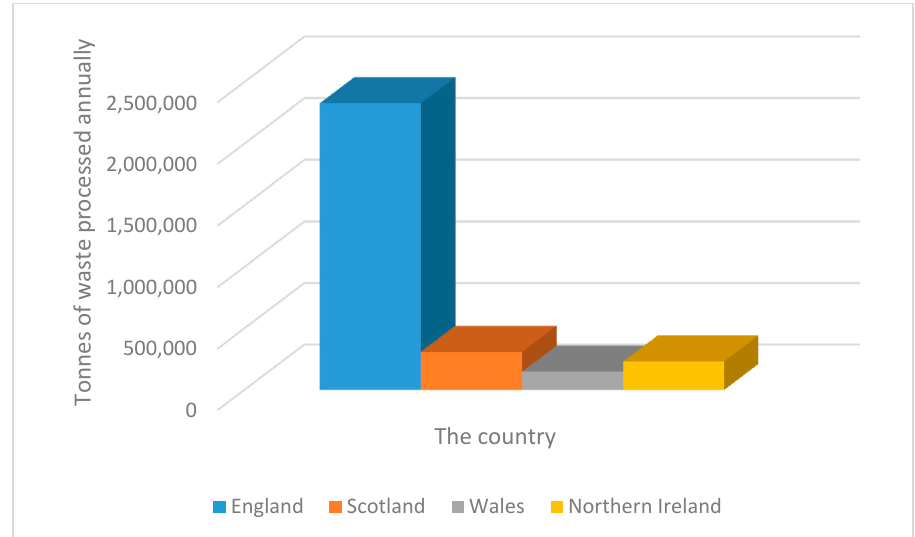
Figure 4. The weight of waste in tonnes processed by certified plants in the countries of the UK; data extracted from Hasznos (2019) shows that England proceed the highest amount of waste per year [127] .